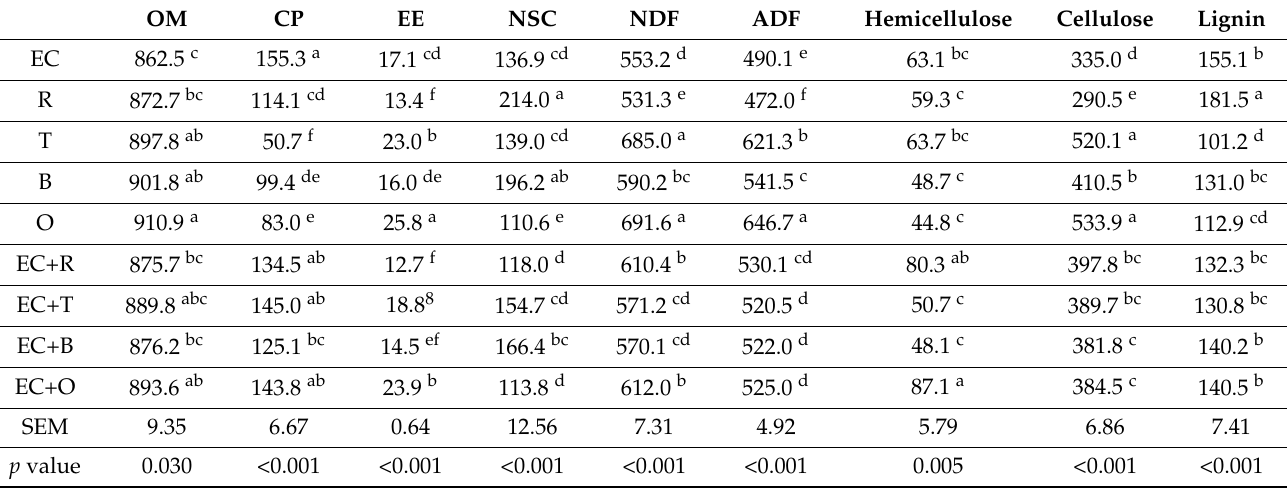
Table 3. Chemical composition (g/kg DM) of intercropping of Egyptian clover/grass.